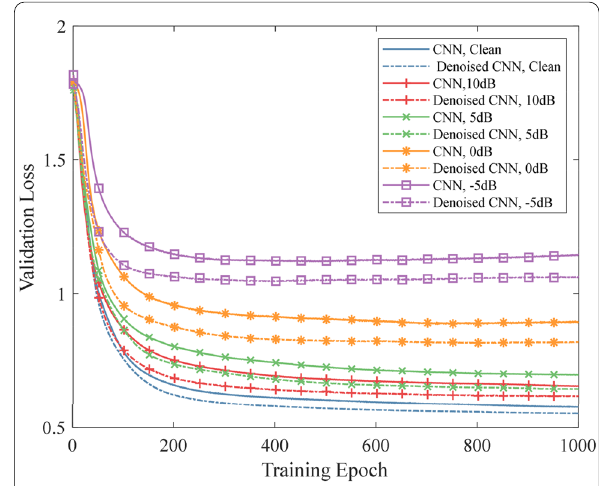
Figure 7 Variance of the validation loss on the bearing dataset based on